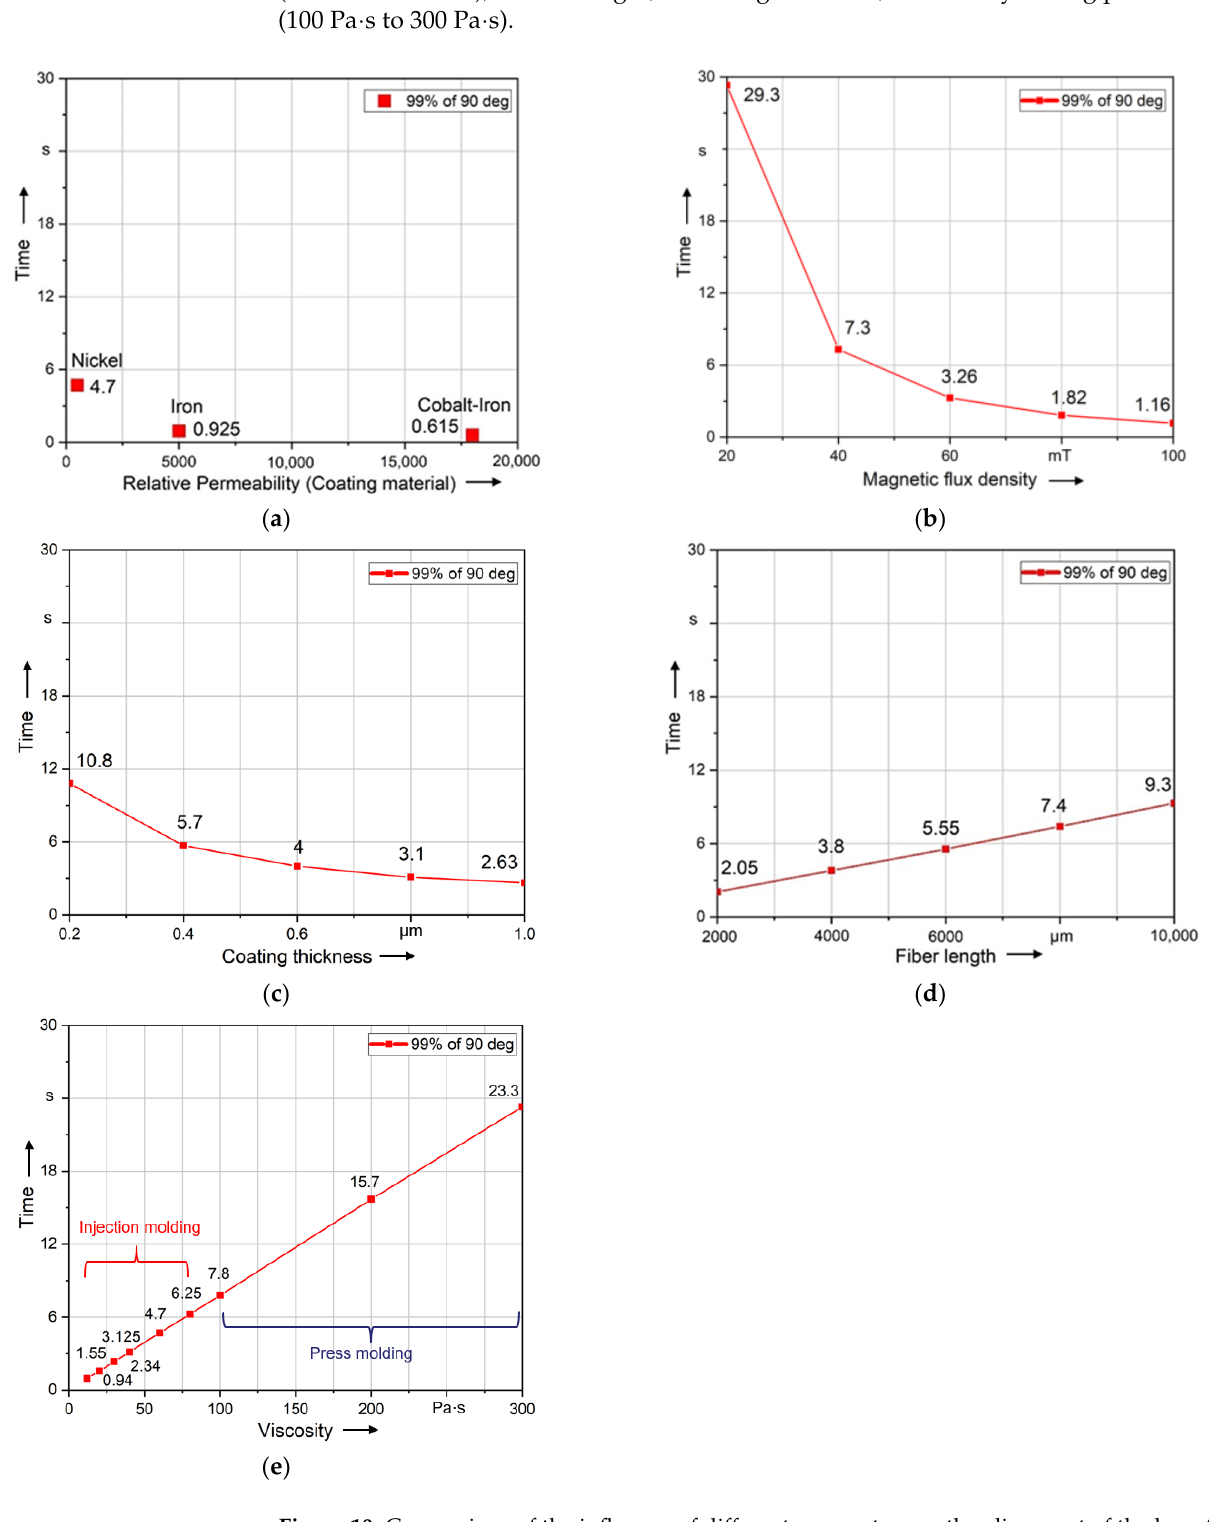
Figure 10. Comparison of the influence of different parameters on the alignment of the long fibers (5000 µm): ( a ) coating material; ( b ) magnetic flux density; ( c ) coating thickness; ( d ) fiber length; ( e ) viscosity.